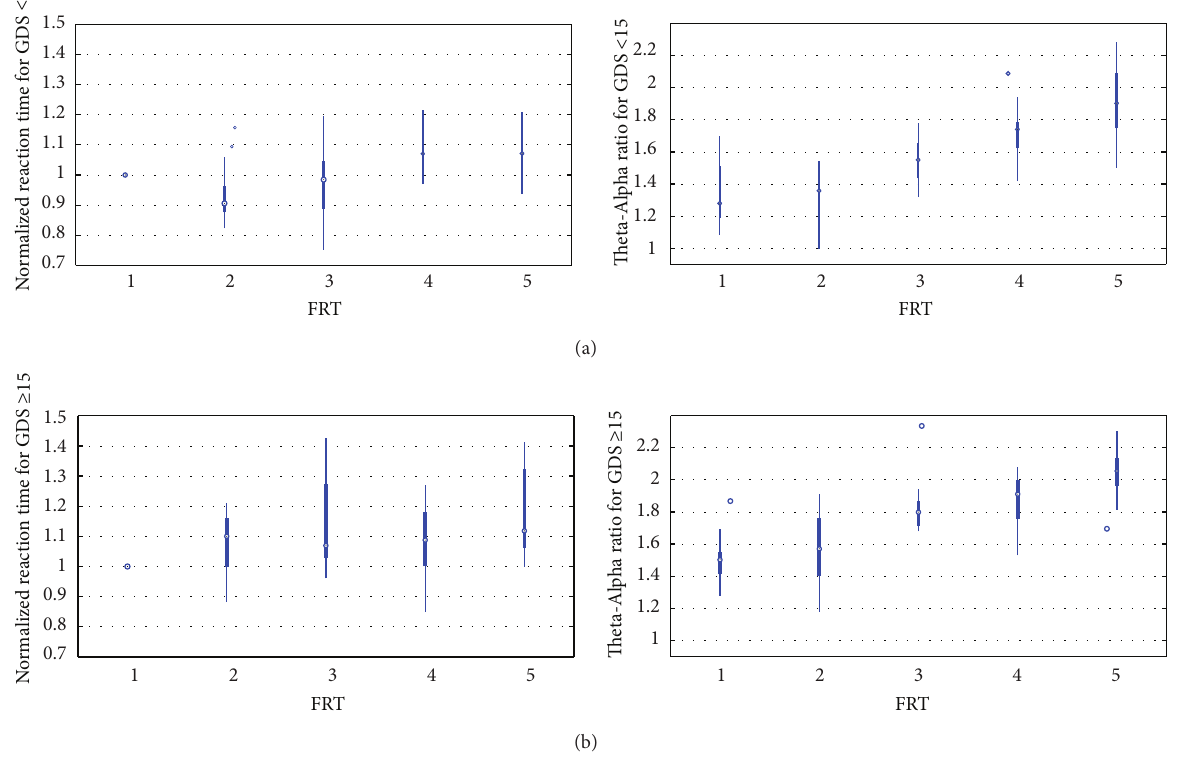
Figure 5: Box plot showing the evolution of baseline-normalized cued response time during modified functional reach tasks (FRT) and the Theta-Alpha power ratio during quiet standing in-between FRT for (a) “nondepressed” (GDS < 15) QEEG group and (b) “depressed” (GDS ≥ 15) QEEG group.